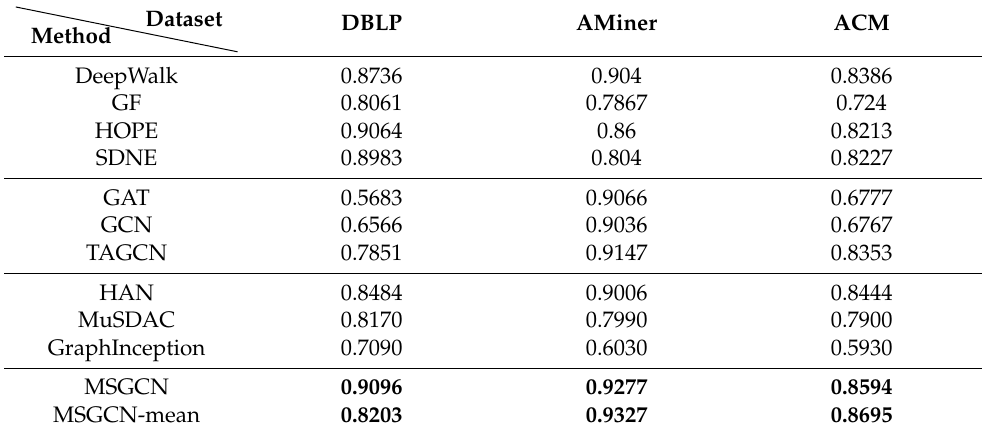
Table 4. Experimental